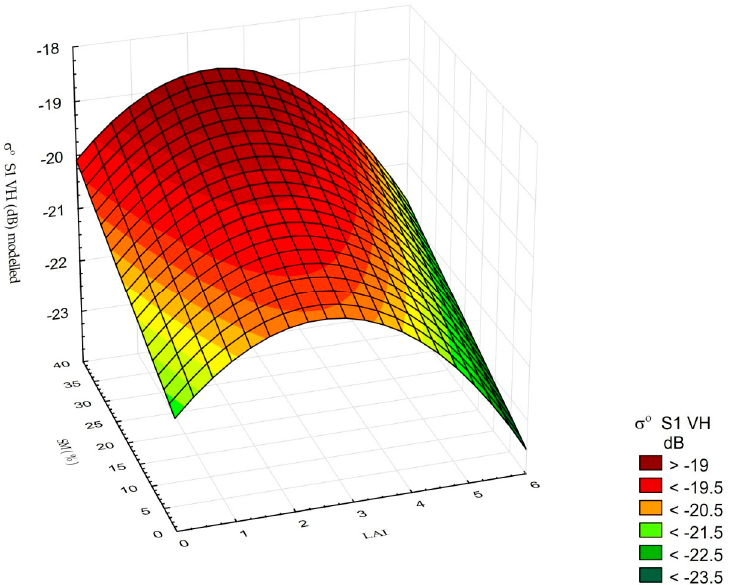
Figure 11. 3D-area plot for Equation (3).